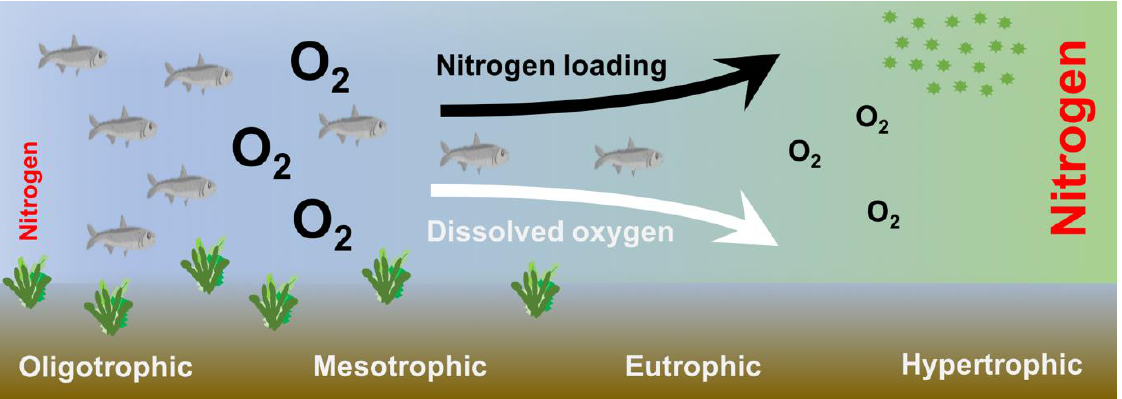
Figure 1. Conceptual schematic of marine eutrophication due to the increased loading of nitrogen (Modified from [37]).